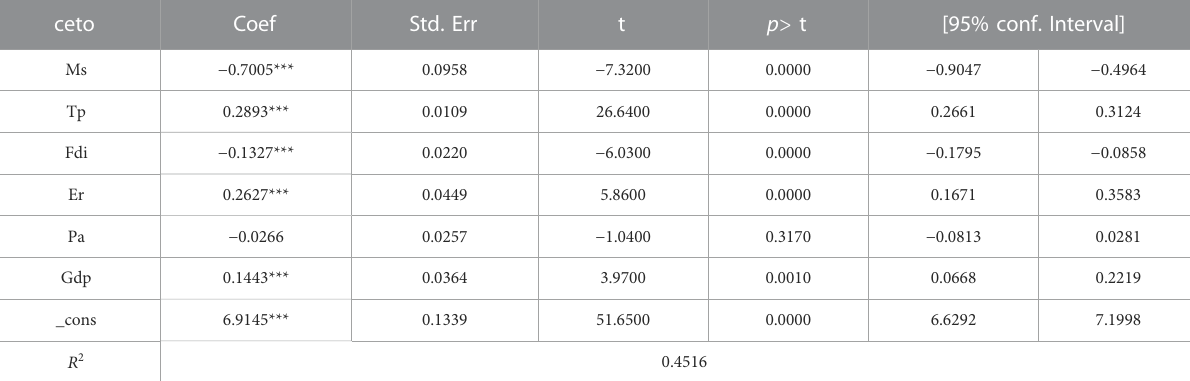
TABLE 4 Fixed effect model estimation of carbon emissions from industrial structure optimization and population agglomeration. ceto Coef